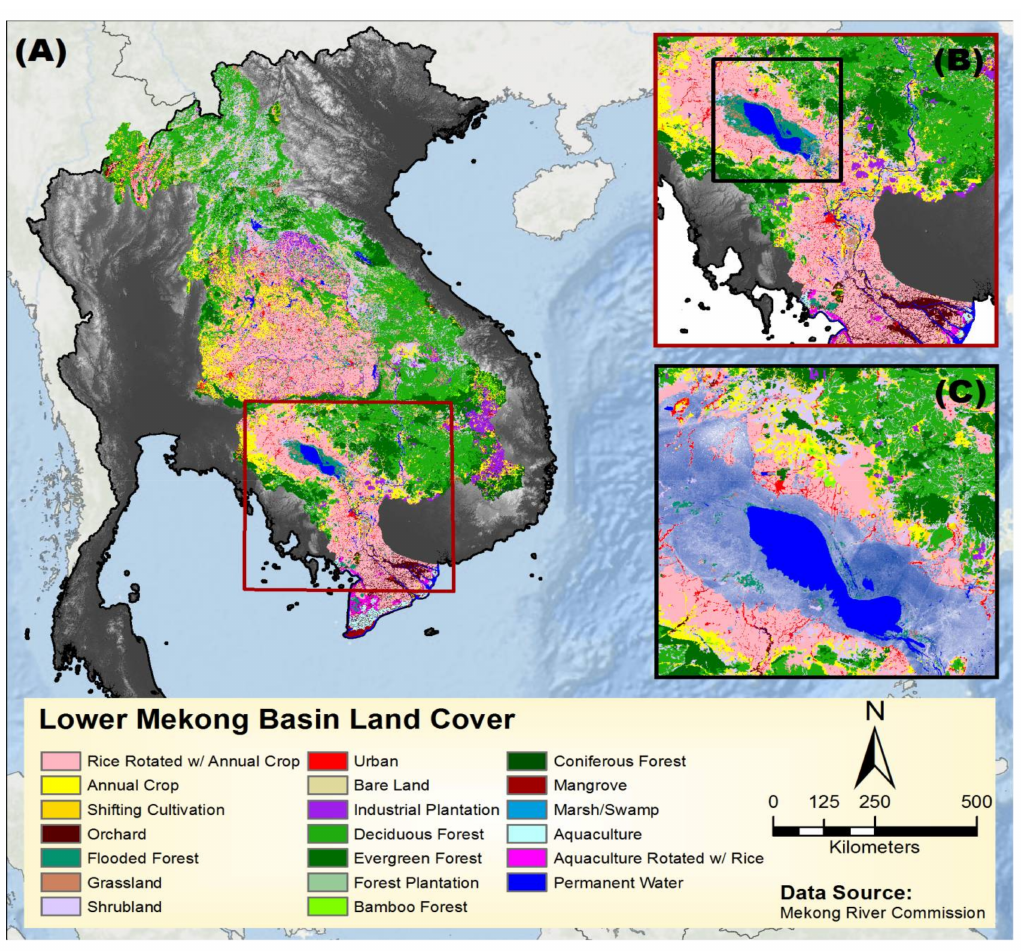
Figure 3. ( A ) Land use/land cover (LULC) map produced by Mekong River Commission (MRC, 2010). ( B ) Inset showing study extent and LULC details considered in this analysis. ( C ) Close view of the Tonle Sap Lake region,